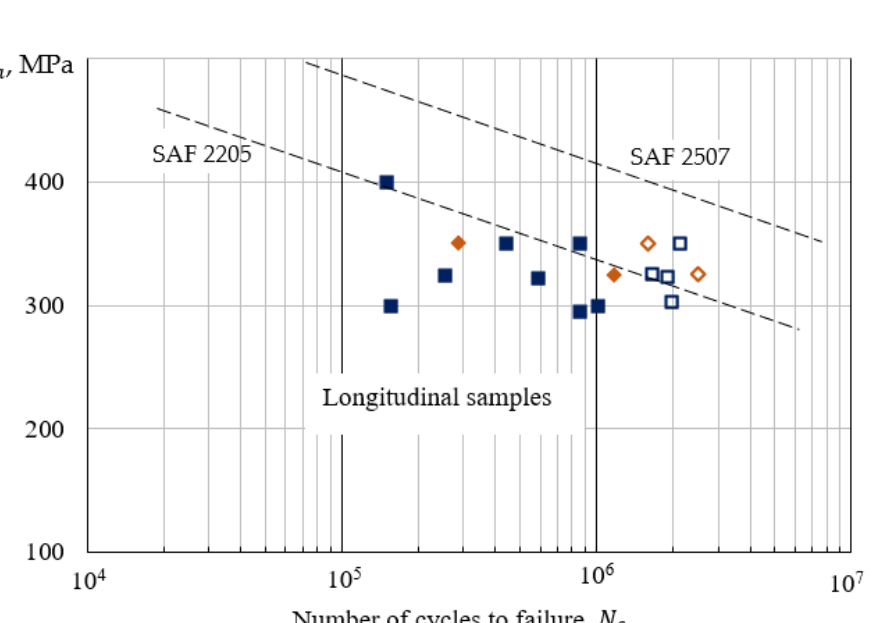
Figure 7. The maximum stress loads σ a of WAAM fatigue specimens in the longitudinal direction versus the number of cycles to failure N f compared with the values for SAF 2507 and SAF 2205 [5]. Unfilled plotted points represent fatigue specimens that did not fail. Squares correspond to the interpass temperature of 150 °C and rhombus represent results of fatigue testing for the interpass temperature of 100 °C or increased cooling time.